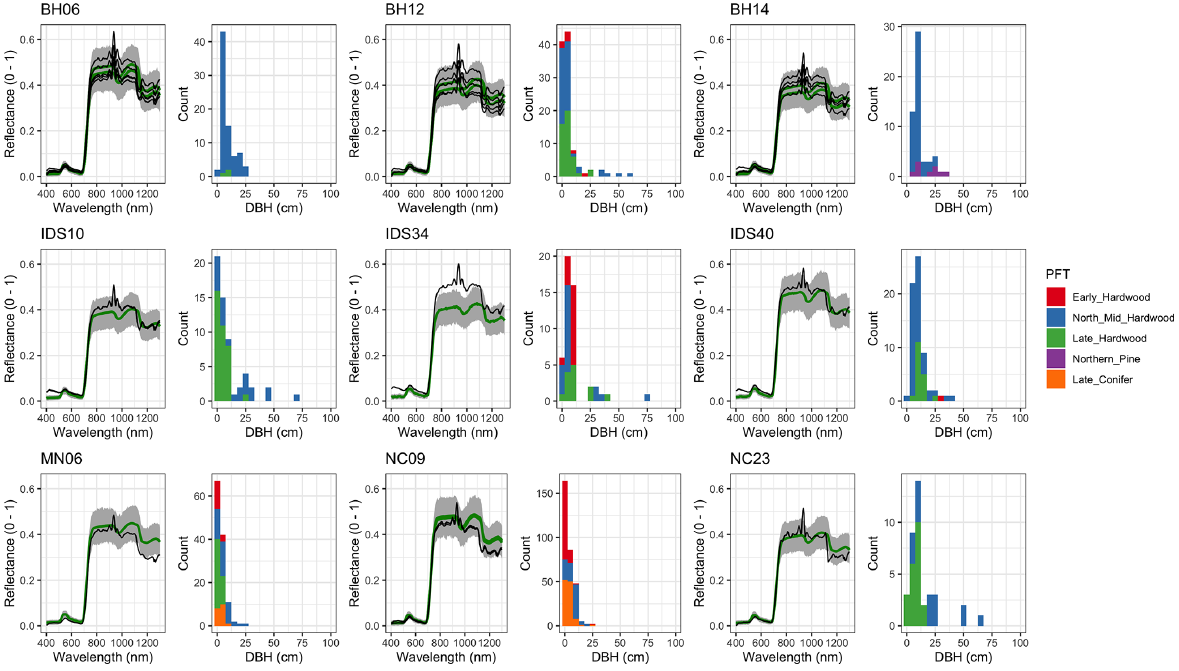
Figure A12. As above but for sites where mid-hardwood trees had the largest mean DBH.